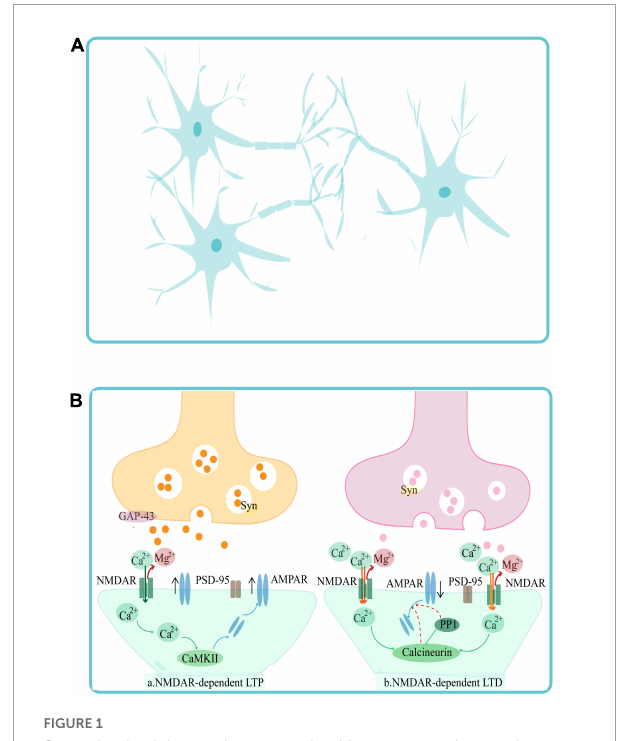
FIGURE1 Synaptic plasticity can be categorized into structural synaptic plasticity (A) and functional synaptic plasticity (B) . Structural synaptic plasticity panel (A) refers to the number, density, distribution of synapses, and highlights the strength of synaptic connections. Functional synaptic plasticity panel (B) refers to the efficiency of synaptic transmission, and includes NMDAR-dependent LTP and NMDAR-dependent LTD.